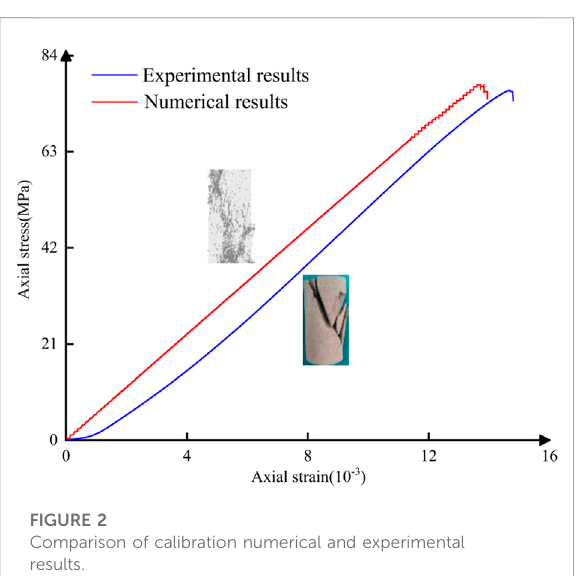
FIGURE 3 Stress-strain curve and fracture number-strain curve of a single fracture-hole rock